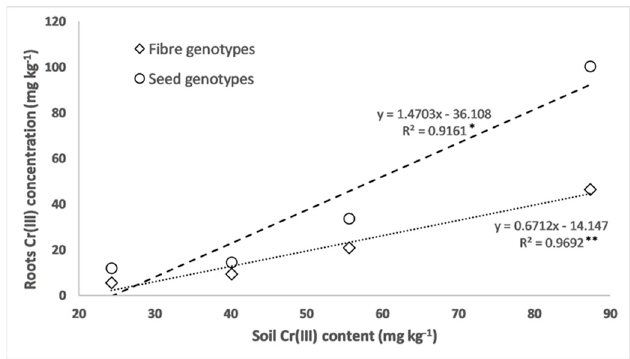
Figure 3. Linear regression between root Cr concentration and soil Cr content for both fiber and seed varieties as a function of hemp type. Significance level of the regression lines is shown at * p < 0.05 and ** p < 0.01